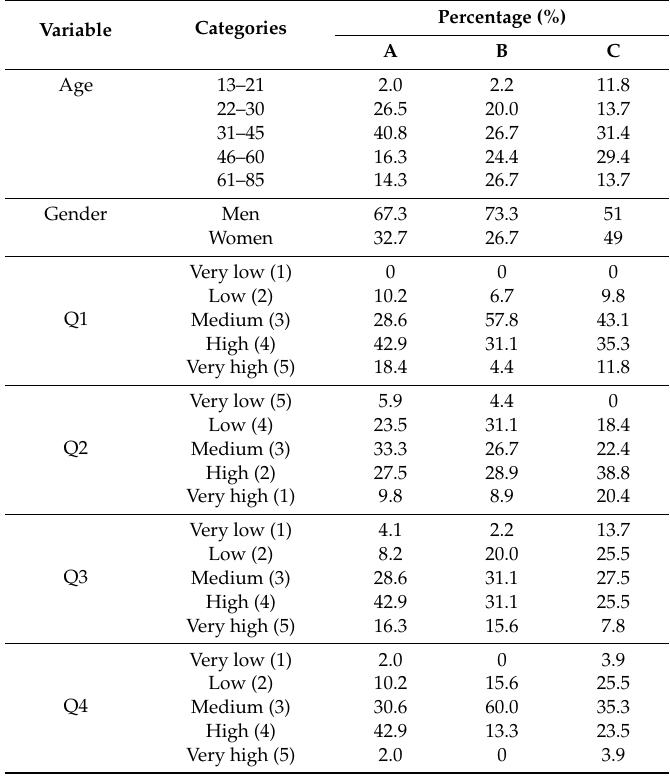
Table 3. The proportional percentages questionnaire data in the three investigated intersections on all the measured